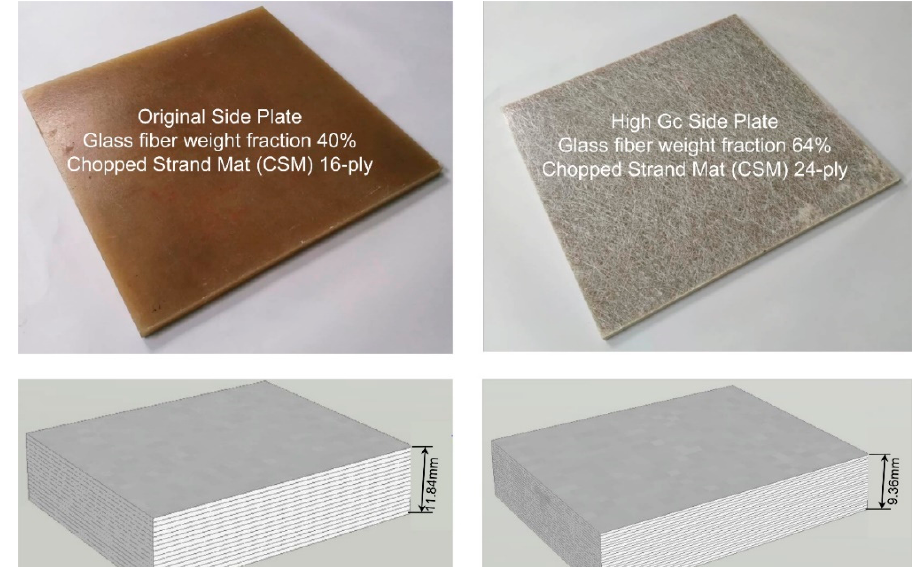
Figure 4. Dimensions of two hull plates and fabricated prototypes. Table 2. Material design for fabrication of two hull side plates.